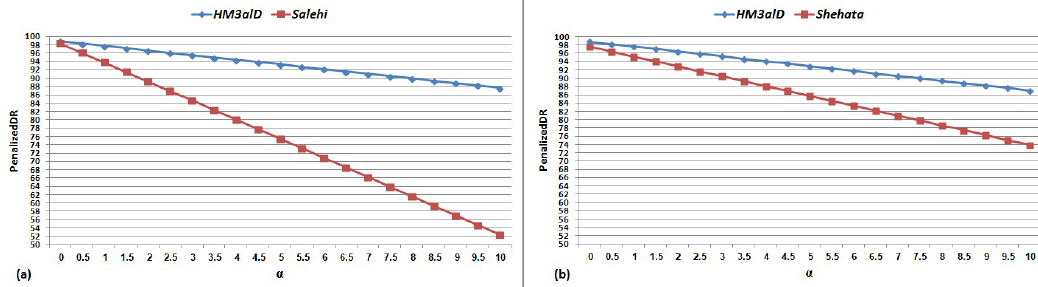
Figure 10. PenalizedDR for HM 3 alD and current dynamic methods: ( a ) Salehi (2017) [23]; and ( b ) Shehata (2015) [22].